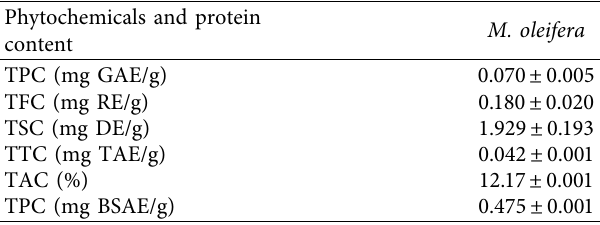
Table 1: Phytochemicals screening and total protein content of M. oleifera